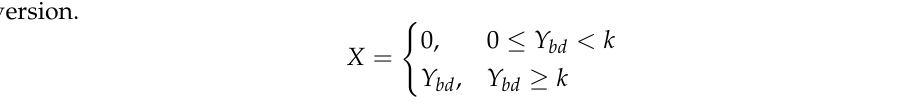
Figure 10. Image filter process ( a – d ): ( a ) original ( Y t ); ( b ) background (Y 0 ); ( c ) difference (Y bd ); ( d ) objective (X).